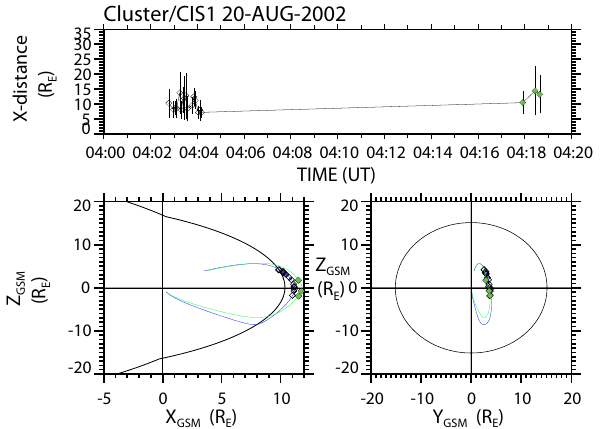
Fig. 8. Same as Fig. 7, but for